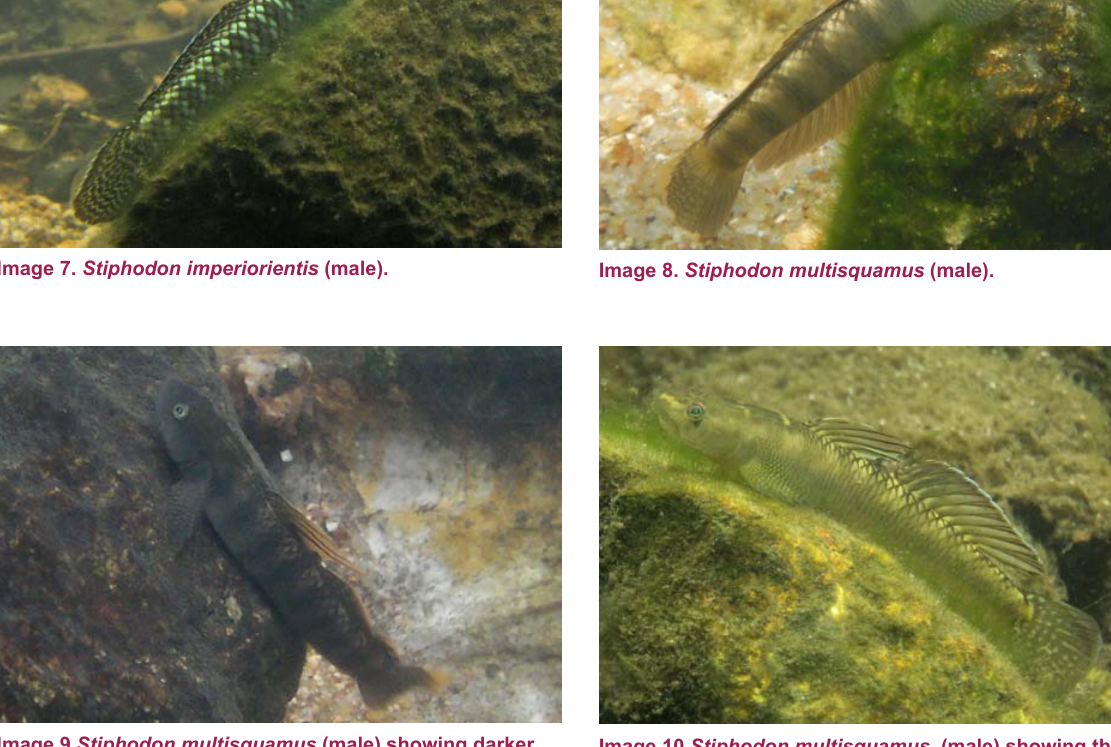
Image 10 Stiphodon multisquamus (male) showing the elongated first dorsal fin.